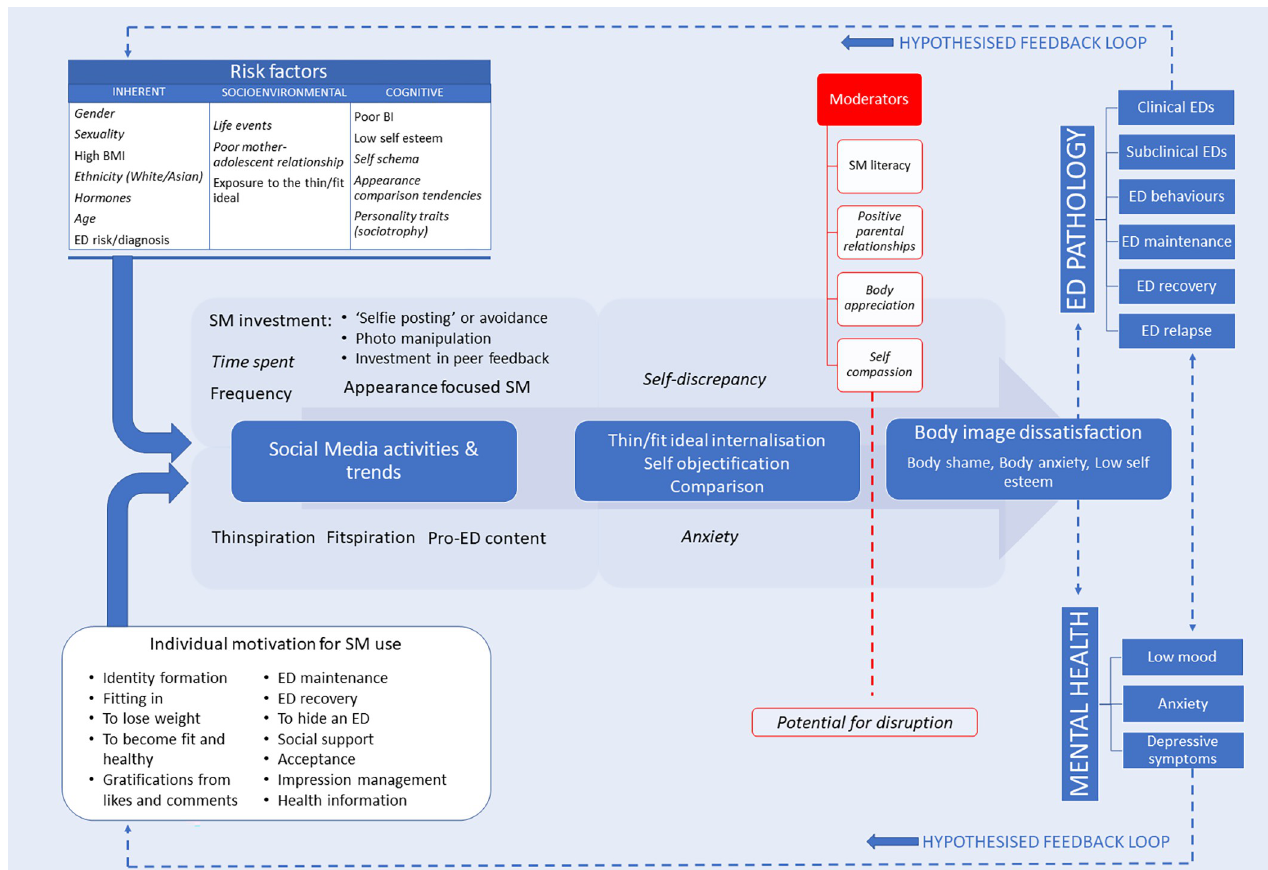
Fig 2. A self-perpetuating cycle of risk to show the relationship between social media usage, body image and eating disorder pathology.